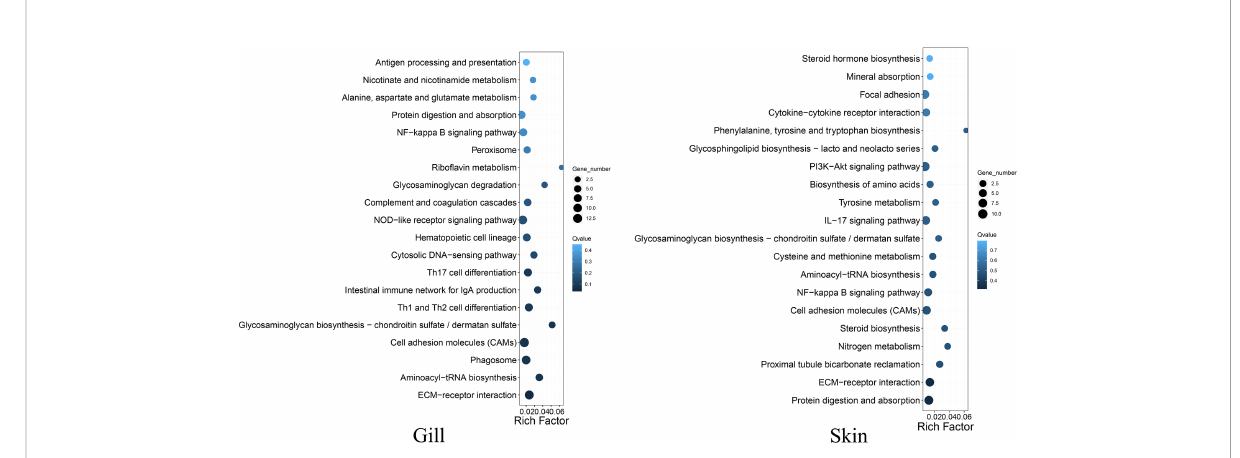
FIGURE 2 Top 20 KEGG pathways enrichments for the DEGs between the resistant and susceptible families of C. semilaevis